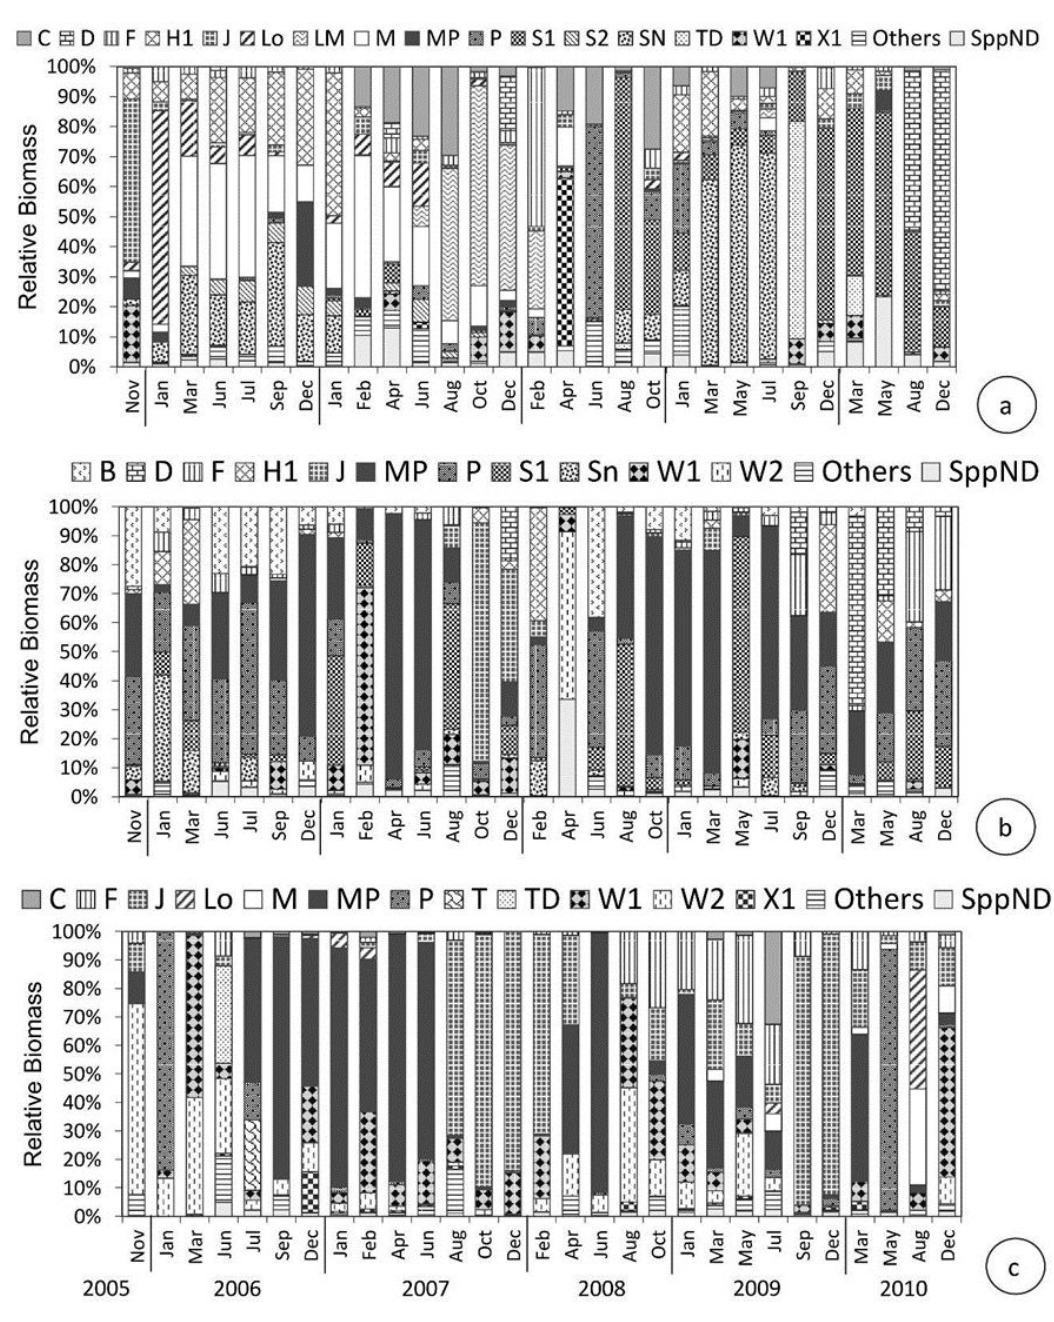
Figure 5. Relative biomass of the phytoplankton functional groups in Soledade (a) and Taperoá (b) reservoirs and Panati lagoon (c) from November 2015 to December 2010. Spp ND: Species not descriptors and therefore not grouped into functional